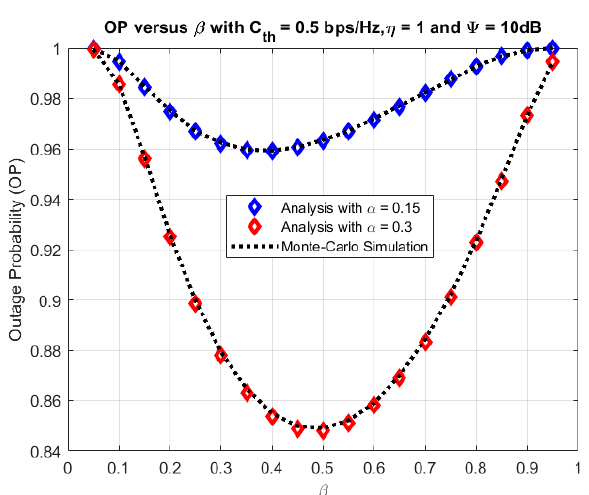
Electronics 2020 , 9 , 428